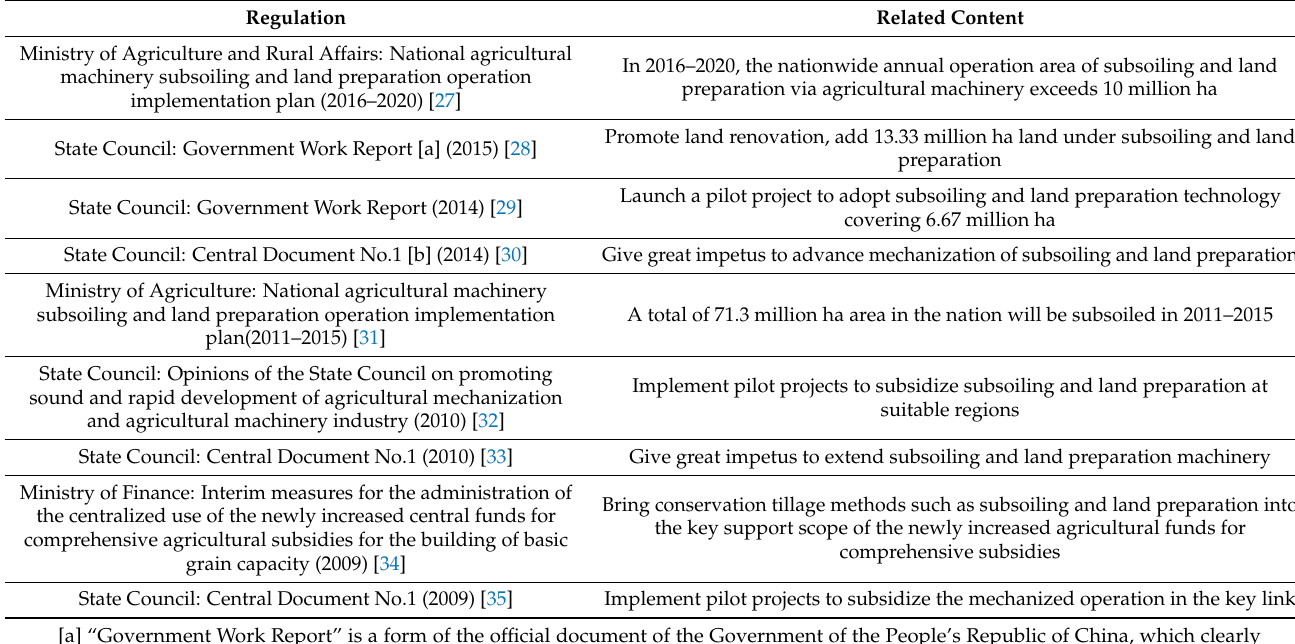
Table 1. Relevant development regulations of subsoiling and land preparation technology in China.